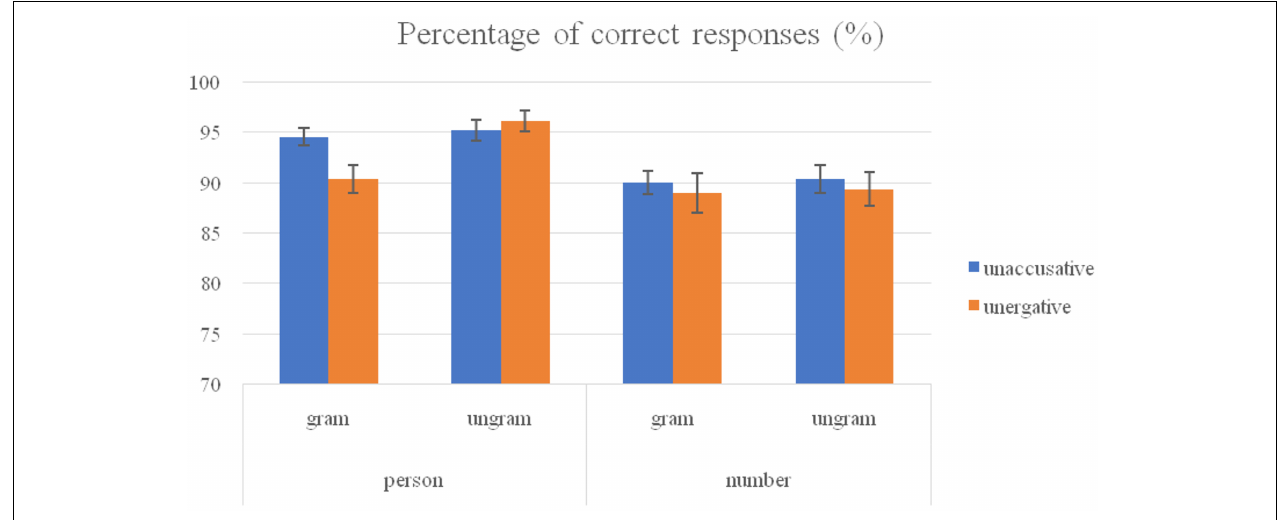
FIGURE 1 | Percentage of correct responses (%) and standard deviation error (SDE) of non-native speakers of Basque.